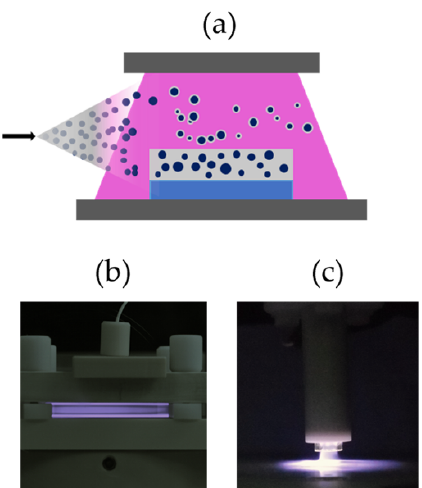
Figure 1. ( a ) Simplified scheme of an aerosol-assisted AP plasma process used for the deposition of nanocomposite coatings. ( b ) Picture of a classical dielectric barrier discharge (DBD) system used for the direct deposition of thin films at atmospheric pressure. ( c ) Picture of an AP plasma jet with DBD configuration used for the remote deposition of thin films.